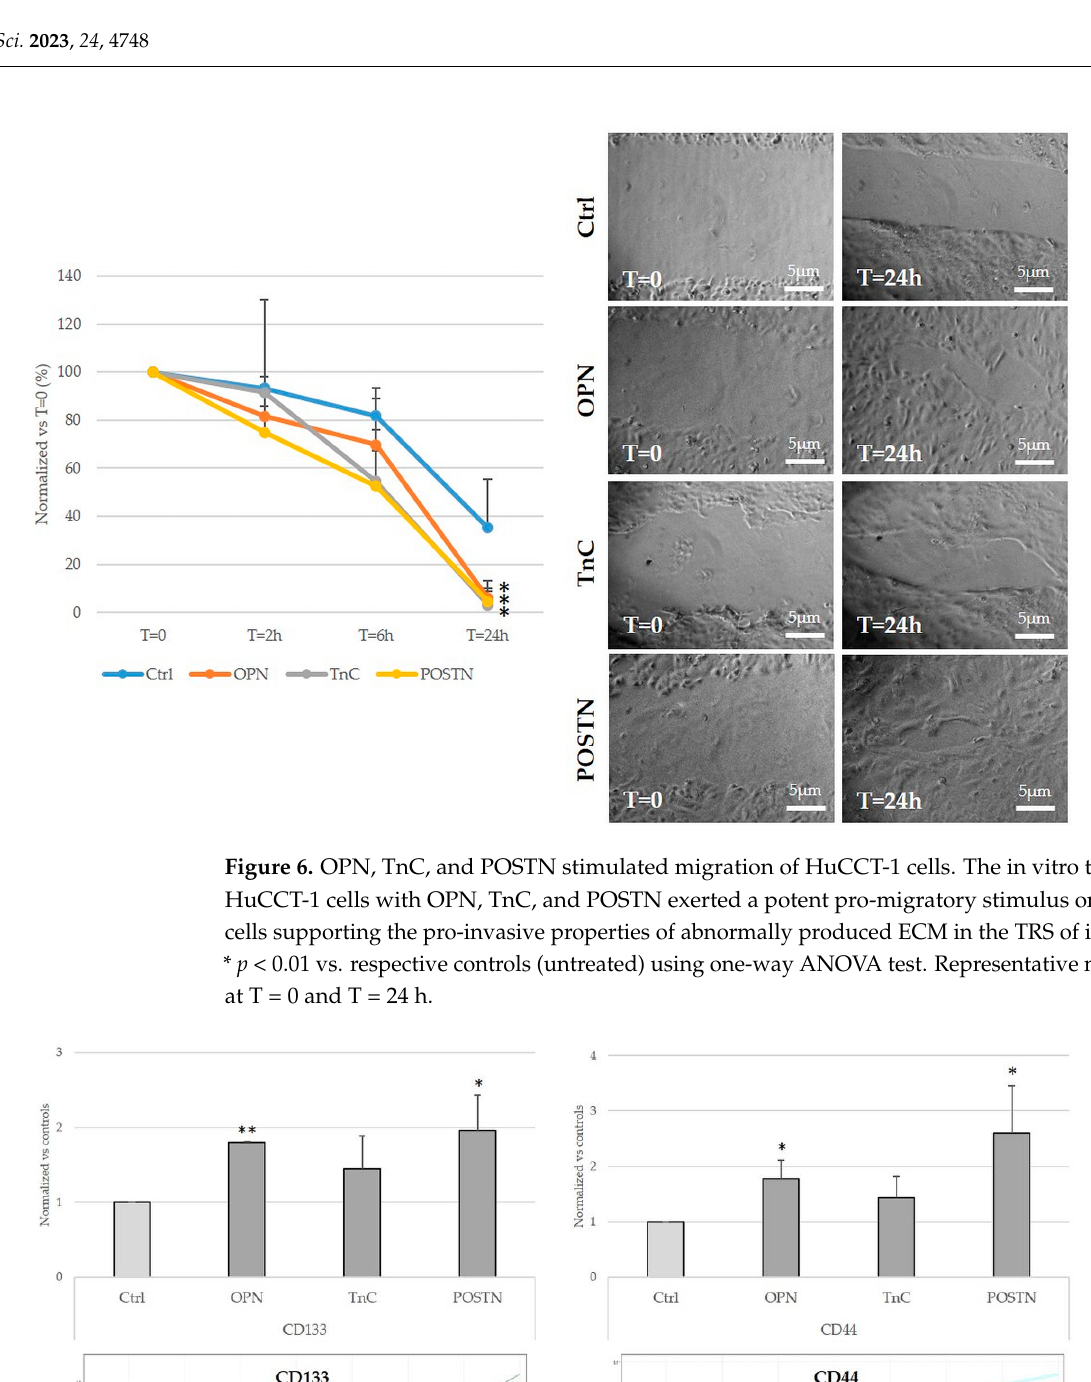
8 of 16 Figure 5. Cell viability of HuCCT-1 cells upon treatment with medium supplemented with OPN, TnC and POSTN. Twenty-four-hour treatment of HuCCT-1 cells with OPN and POSTN, but not with TnC, induced slight increase in cell viability; n = 4 to 6 in duplicate for each experiment. * p < 0.01 vs. controls (untreated) using one-way ANOVA test. 2.5. Treatment with OPN, TnC, and POSTN Potently Stimulated iCCA Cell Motility